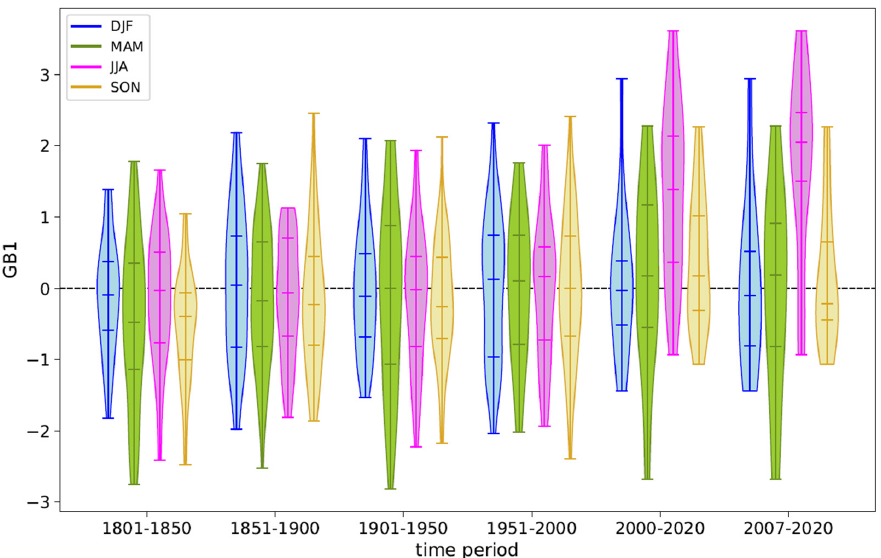
Figure 4. Violin plots showing the distribution of seasonal annual GB 1 values for selected periods. The median and quartiles are shown by horizontal lines, and there is a kernel density estimate of the sampling distribution.